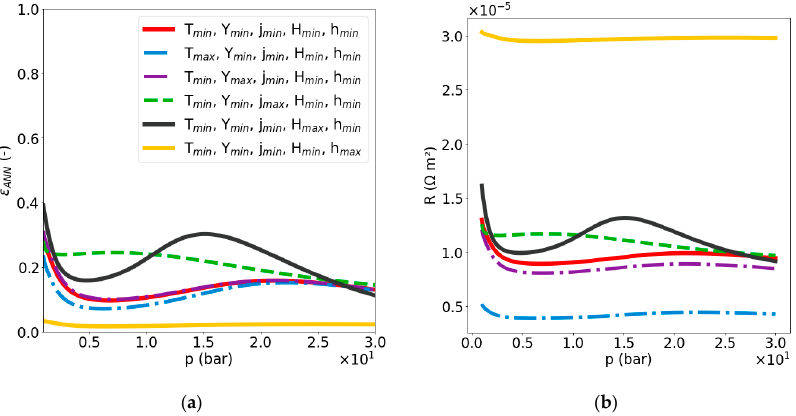
Figure 4. Void fraction 𝜀 (cid:3002)(cid:3015)(cid:3015) ( a ) and ohmic resistance 𝑅 ( b ) depending on the pressure in [1–30] bar.